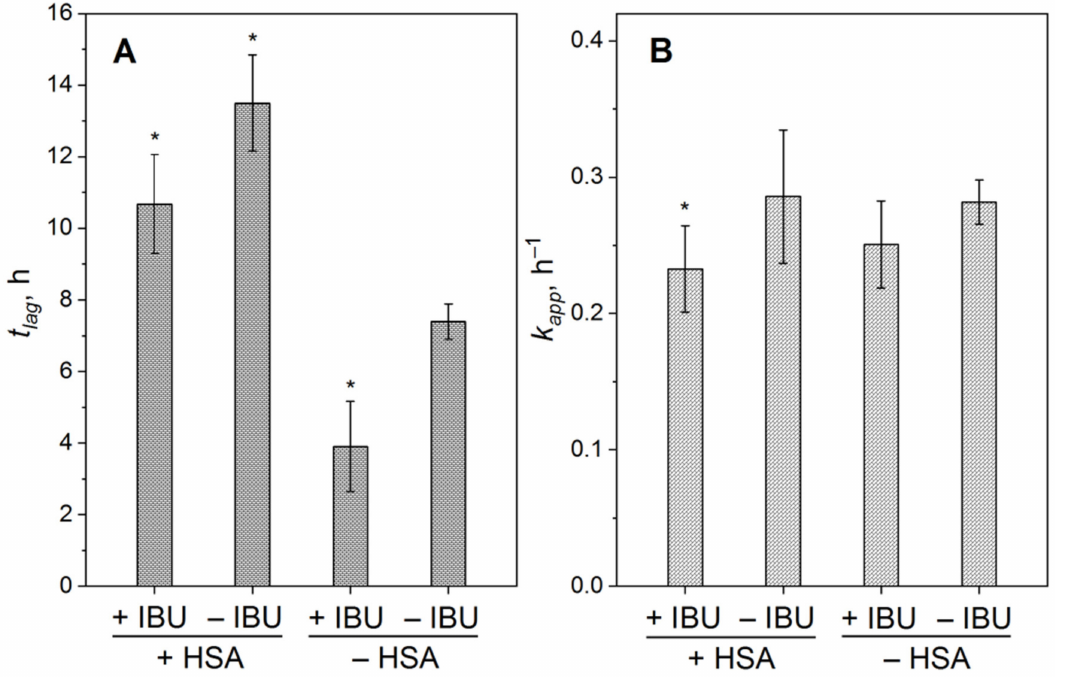
Figure 4. The lag time t lag ( A ) and rate constant k app ( B ) of A β 40 fibrillation at 30 ◦ C, estimated from the ThT fluorescence assay data (Figure 3A; 2 µ M HSA, 20 µ M IBU) using Boltzmann sigmoid function (Equation (2)). The standard deviations are shown (n = 3–5). The statistically significant differences from the experiments in the absence of HSA and IBU are indicated by * (Student’s t -test, p =